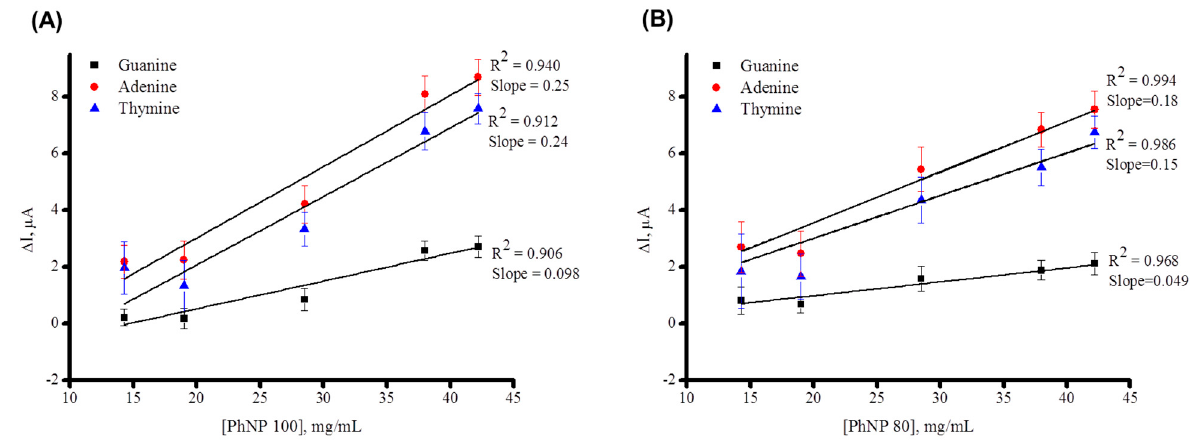
Figure 2. The dependence of the DPV maximum amplitude of the dsDNA oxidation current, calcu- lated as ∆ I = I(dsDNA) − I(dsDNA/PhNP), ( A ) in the presence of PhNP100, ( B ) in the presence